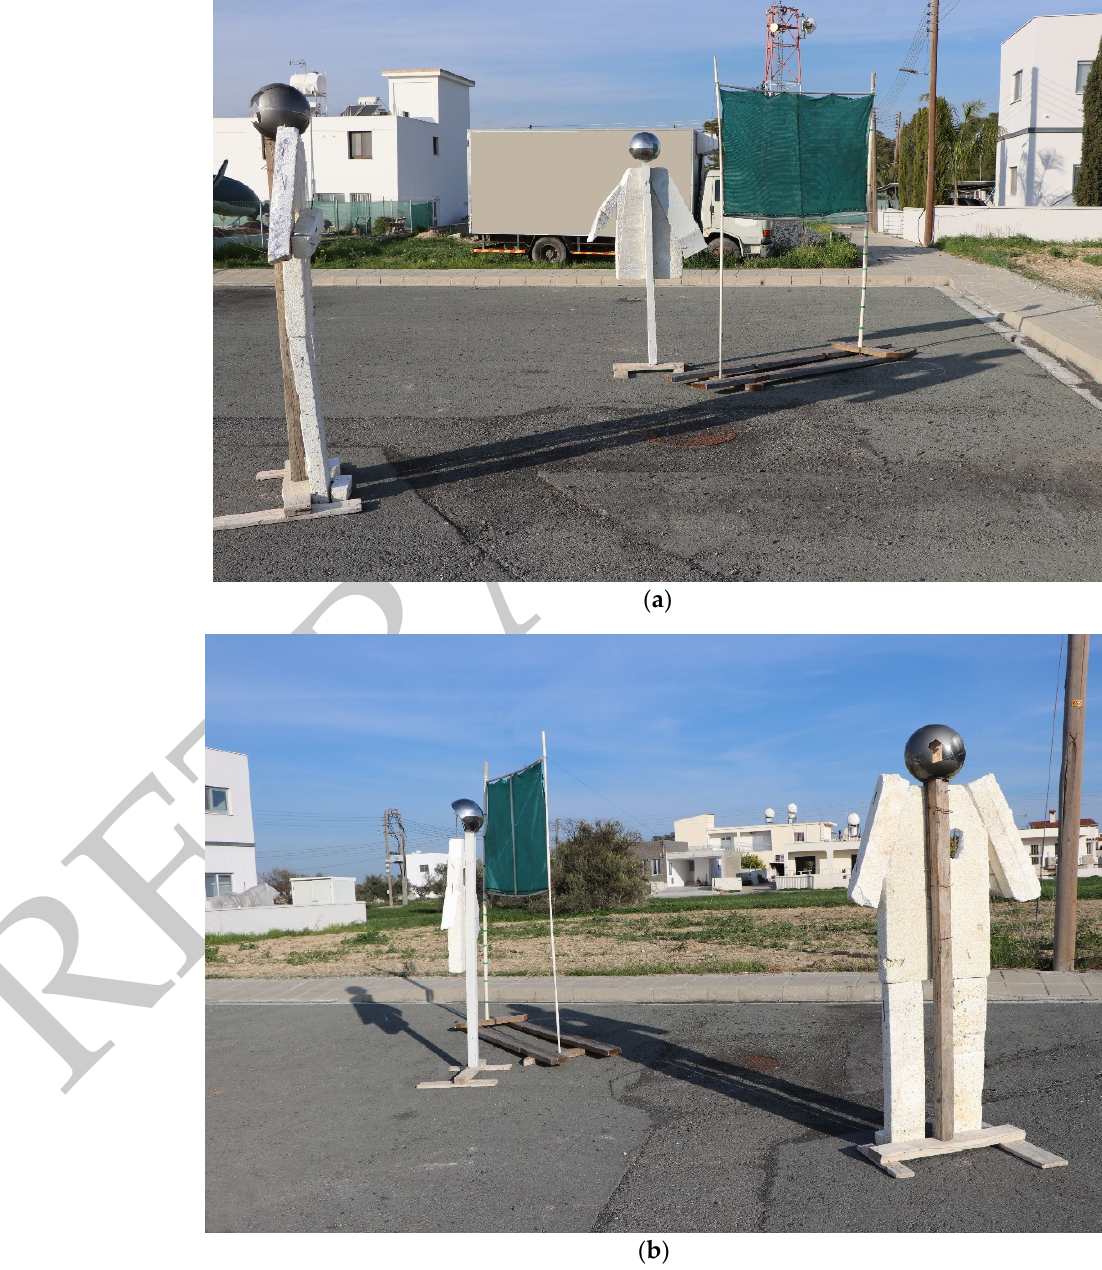
Figure 20. ( a , b ) Reproductions of photo AS17-134-20384 from different angles. The images taken at the correct position of the Sun (17° altitude), show the imaged astronaut, flag, and helmet and the photographer astronaut with its created shadow. Photos cleared from irrelevant objects.